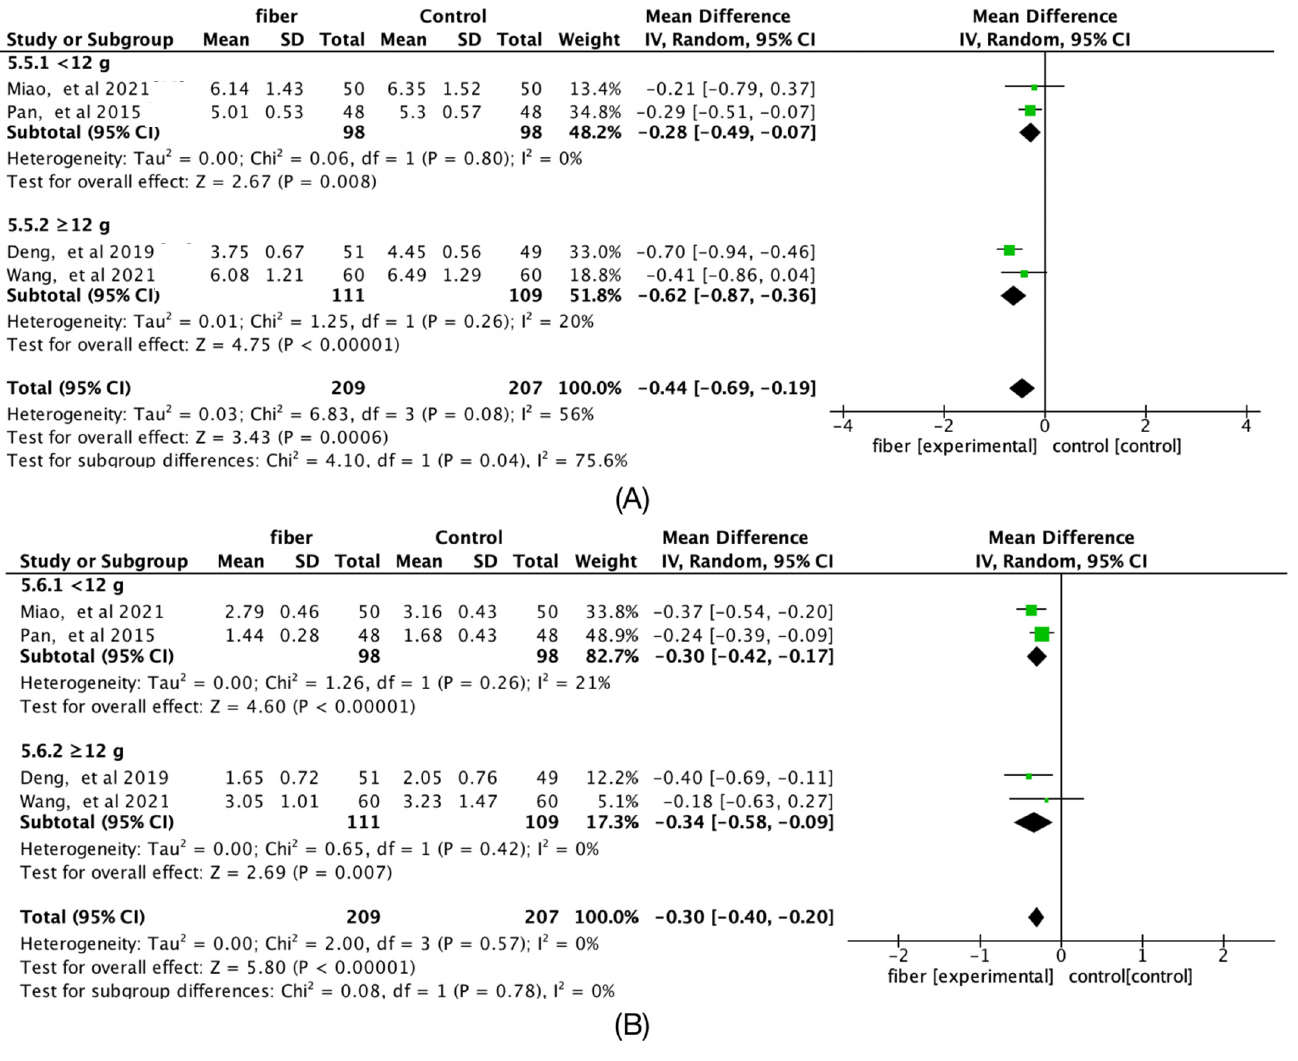
Figure 8. Forest plots of subgroup analysis of fiber quantity on ( A ) Total cholesterol (TC, mmol/L) and ( B ) Triglycerides (TG, mmol/L).[15,16,18,20]